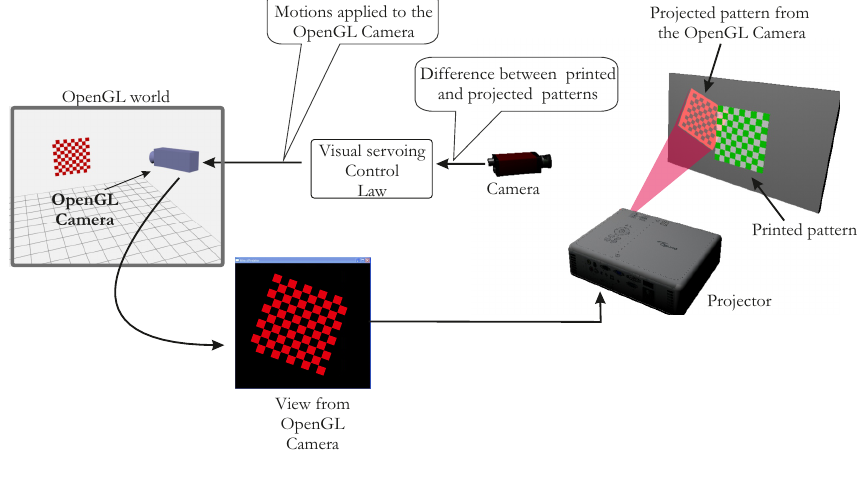
Figure 2. Overview of the setup: The virtual camera looks at a virtual printed pattern displayed by the